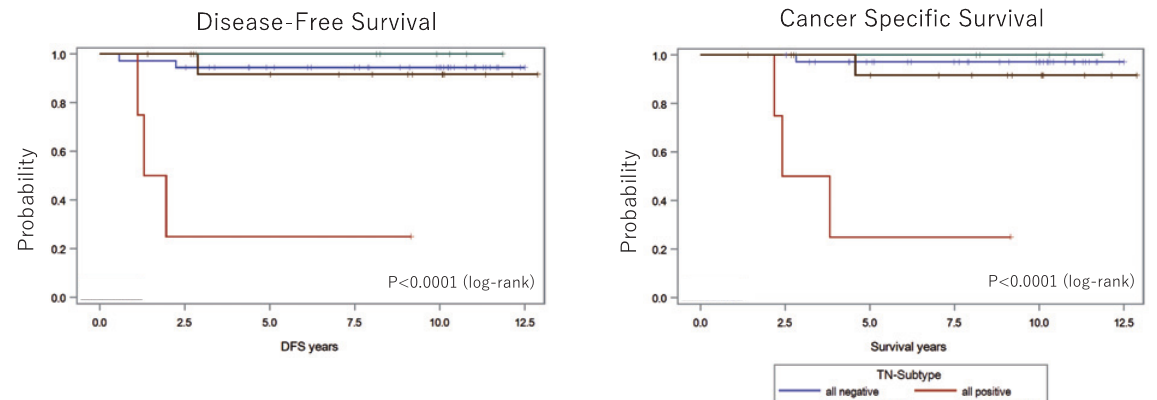
F i g ure 3. DFS and CSS amon g triple ne g ati v e s u b g ro u ps classified b y c-Kit and HIF-1 α expression. Disease-free s u r v i v al (DFS) and cancer-specific s u r v i v al (CSS) amon g triple-ne g ati v e s u b g ro u ps clas- sified b y c-Kit and HIF-1 α expression. The g ro u p w as classified into fo u r s u b g ro u ps b y c-Kit and